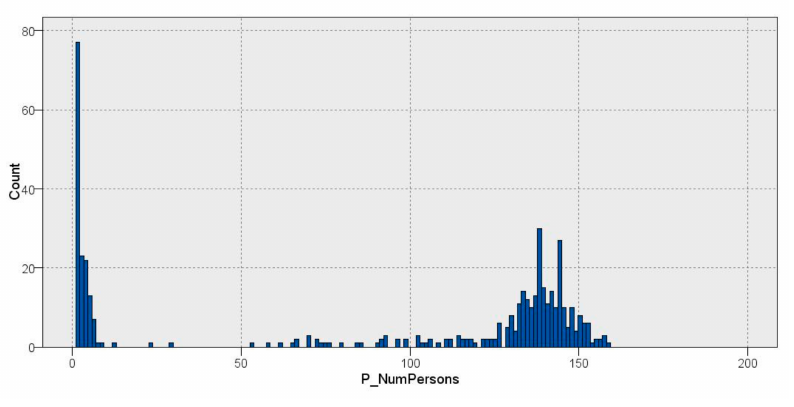
Figure 2. Occupancy distribution.